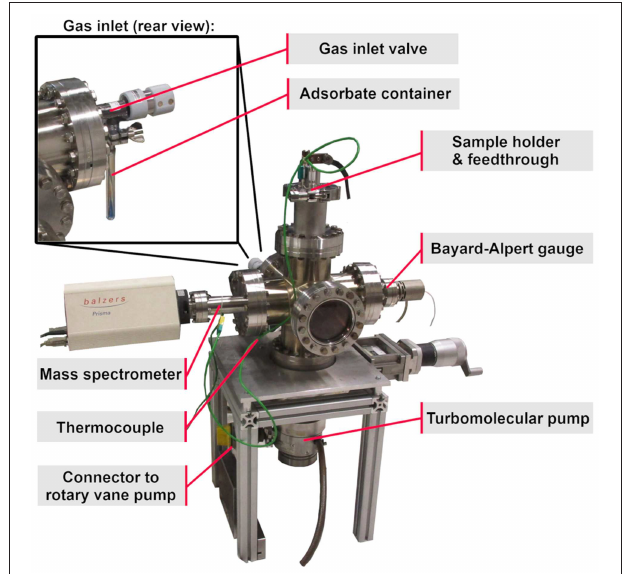
FIGURE 1 | TPD-System, overview.